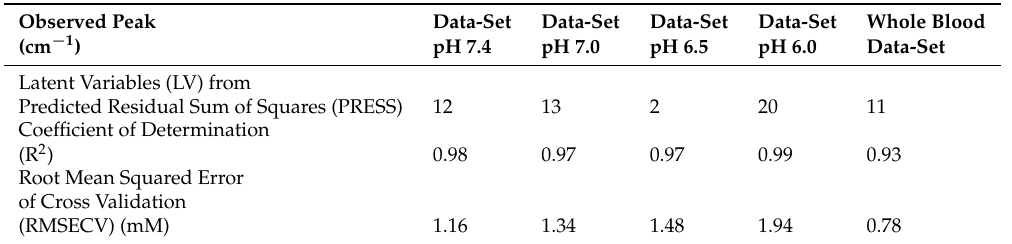
Table 3. The Coefficient of Determination (R 2 ) and Root Mean Squared Error of Cross Validation (RMSECV) (mM) for each data-set, independently, in the region 1500–600 cm − 1 .